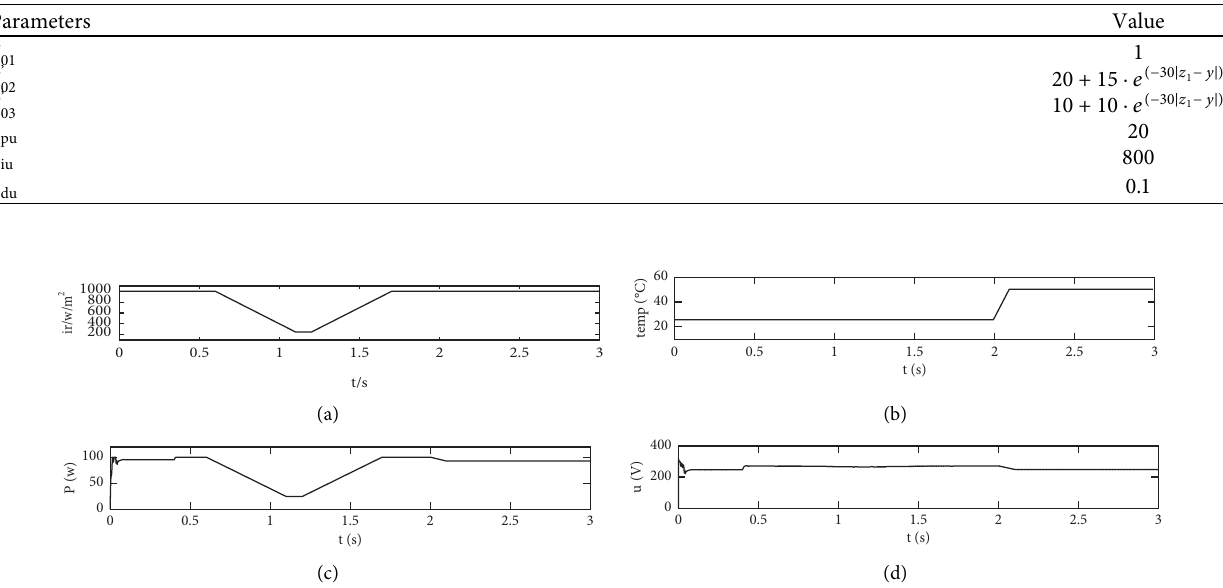
Table 2: Parameters of the controller.